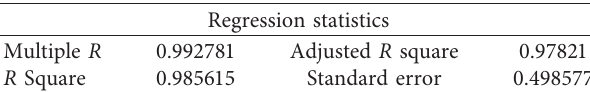
Figure 3: The price frequency histogram and price density distribution. Table 3: Linear regression analysis results on film